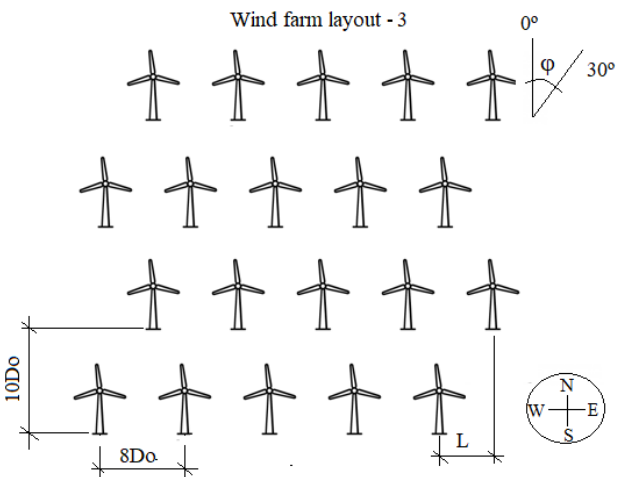
Figure 9. Modified wind farm (layout 3) considering row offset.